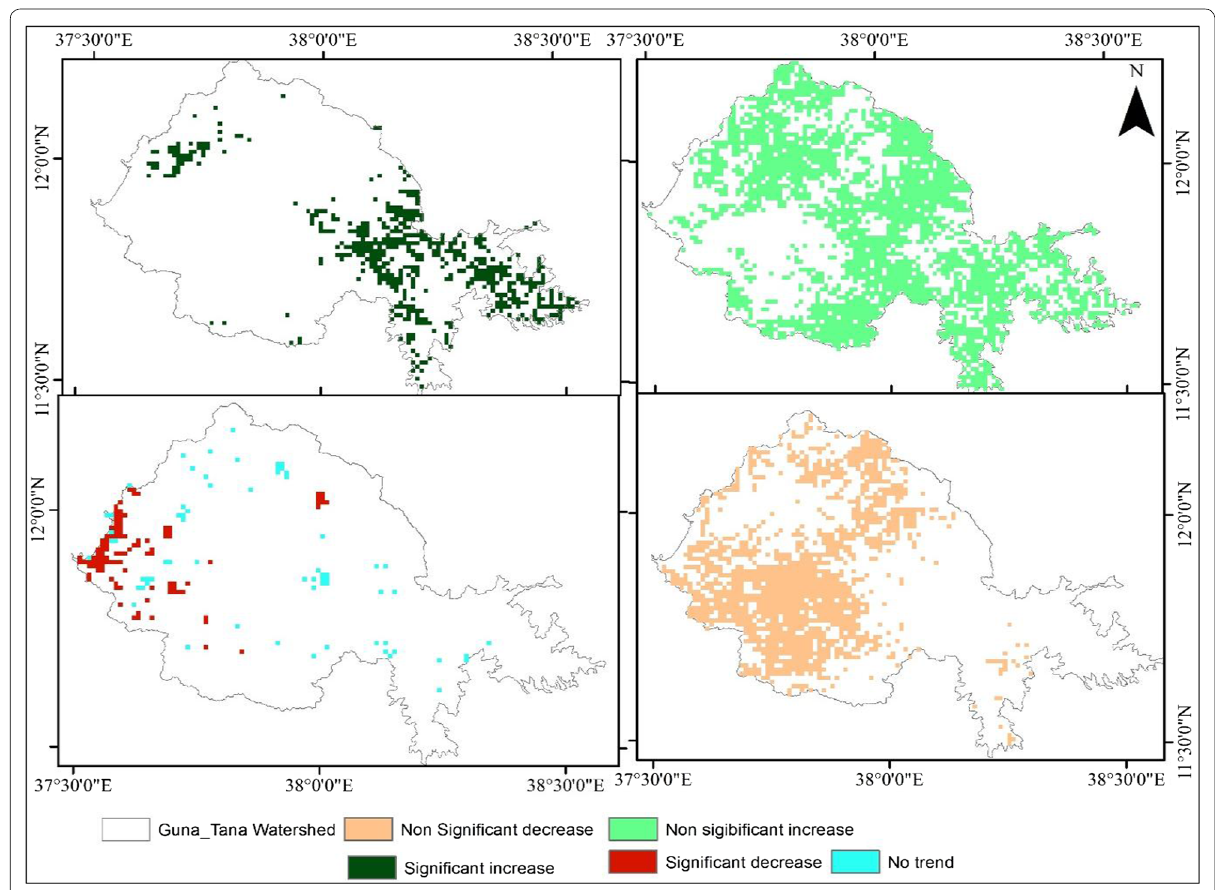
Fig. 6 Spatial patterns of trends in vegetation productivity (NPP) in Guan-Tana watershed